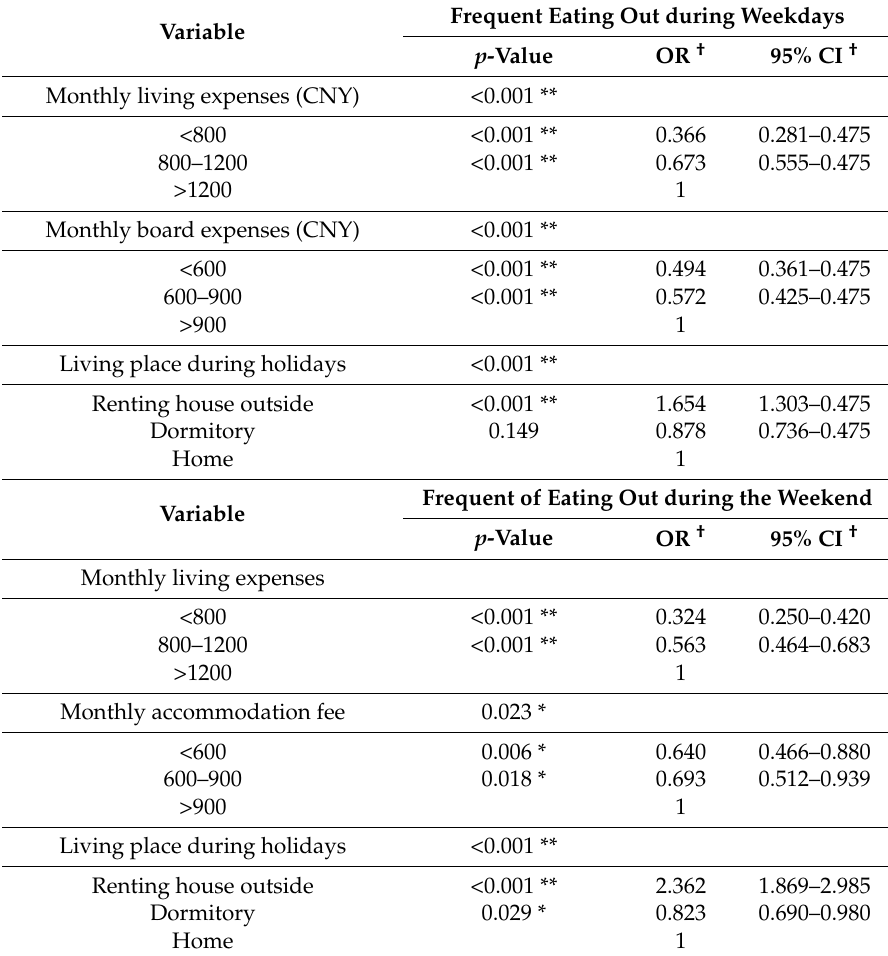
Table 3. Logistic regression for the factor effects of the frequency of eating out.